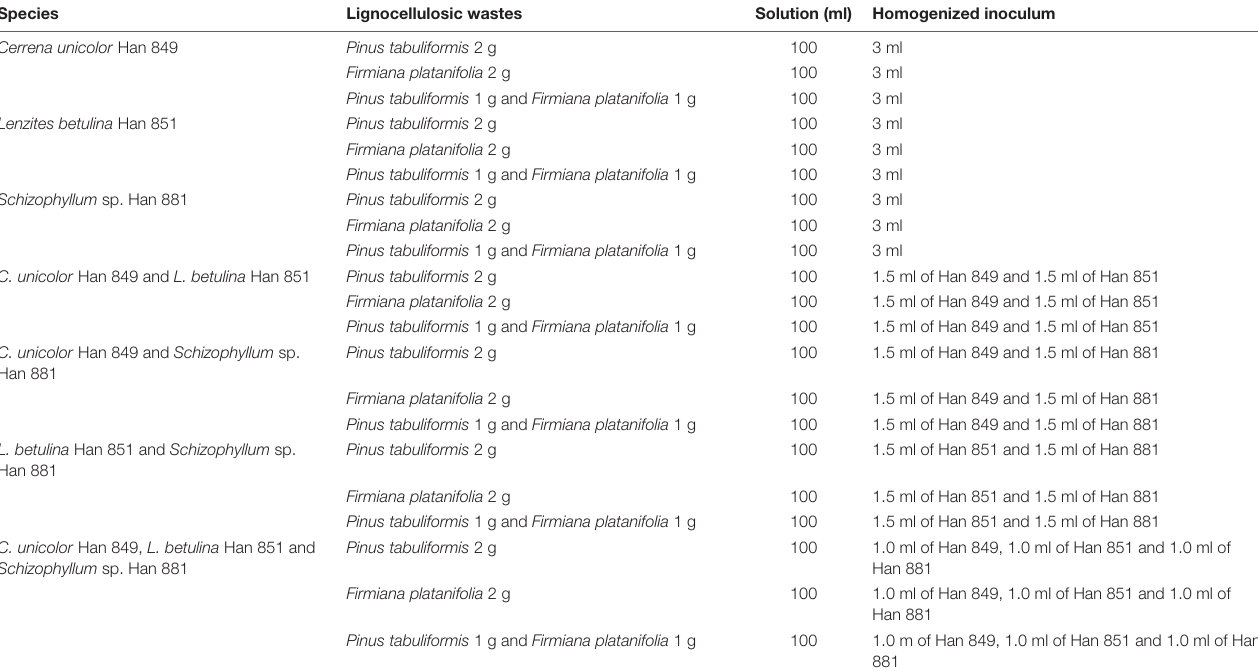
TABLE 1 | Description of each component of the experimental group. Species Lignocellulosic